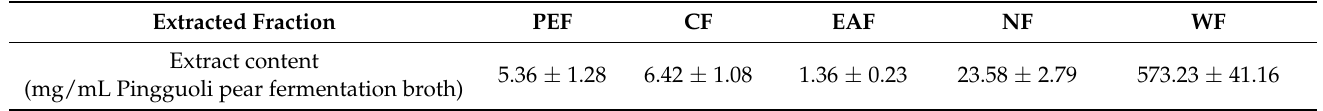
Table 1. Content of extracts from Pingguoli pear fermentation extracted by different solvents. Extracted